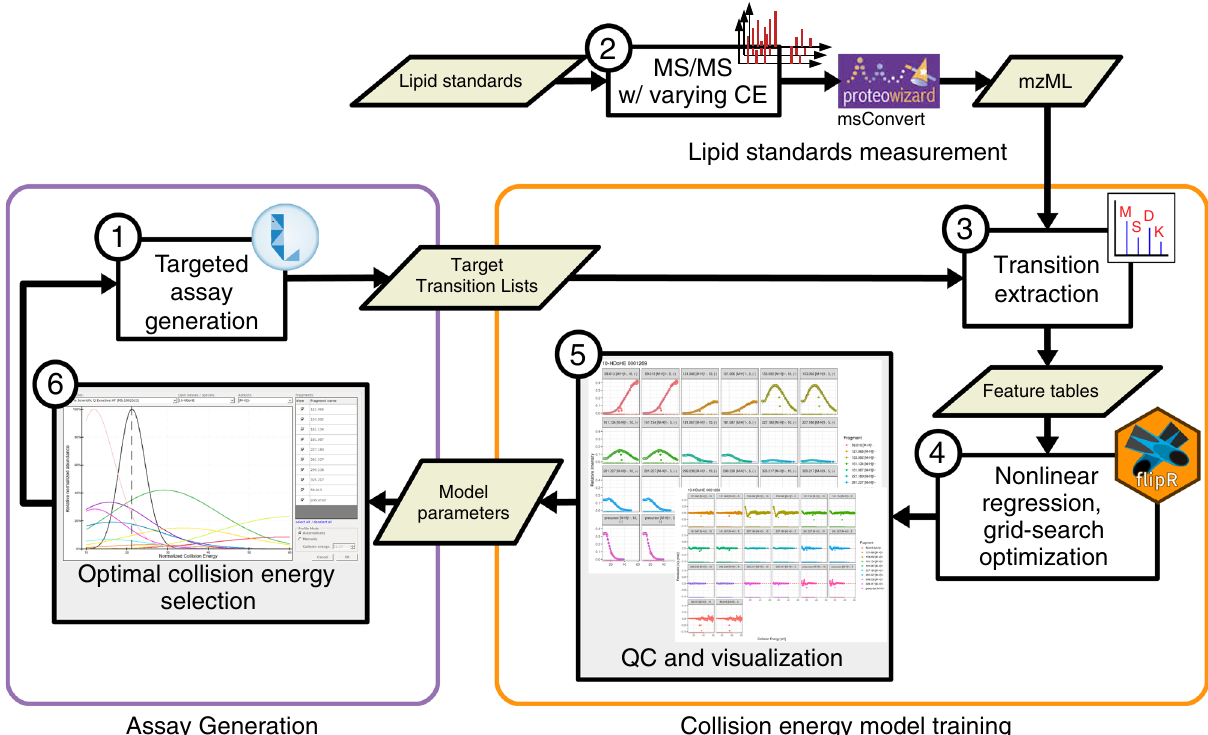
Fig. 3 Relative fragment intensity prediction for collision-energy optimization. The work fl ow is connecting the assay development with LipidCreator (1), lipid standards measurement (2) and transition extraction from the measured data to create feature tables (3) for the training of fragment-speci fi c nonlinear regression models for collision-energy-dependent, relative intensity prediction using nonlinear regression models (4). The subsequent QC and visualization step (5) supports model fi t quality inspection and selection of the parameterized model parameters. LipidCreator uses these model parameters to calculate the optimal collision energy for a lipid based on the selected fragments (6) for further assay re fi nement and integration with the MS acquisition work fl